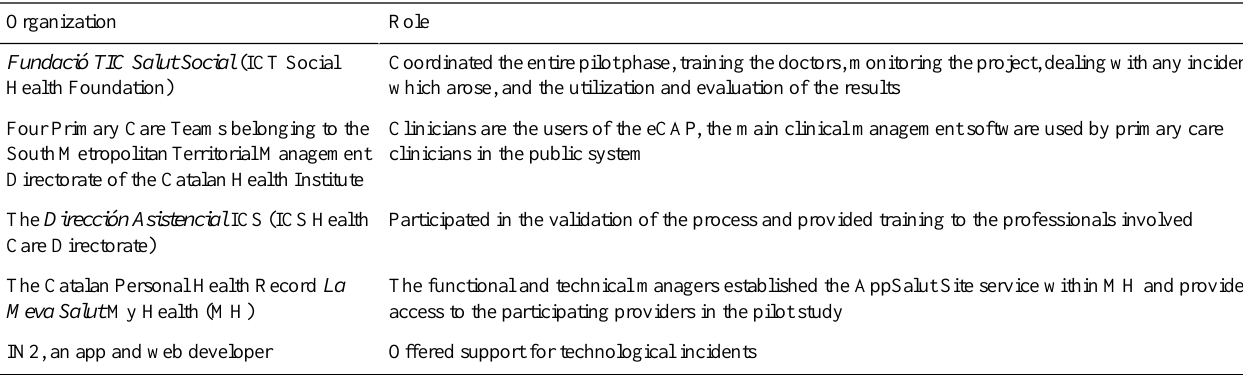
Table 1. The roles of organizations participating in the study.